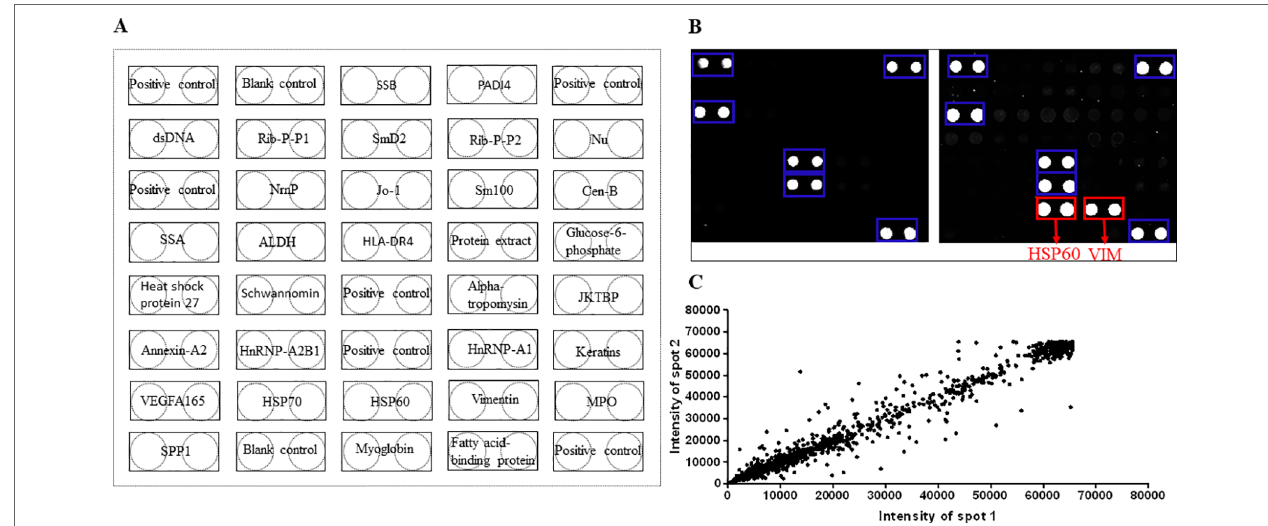
FIGURE 2 | Construction RA associated protein chip. (A) Human proteins were purified and printed in duplicate on poly-L-lysine coated microscope slides. (B) Correlation of spot intensities of all the duplicate pairs. The signal intensities of duplicate spots (Spot 1 versus its corresponding Spot 2) were plotted against each other. The resulting correlation coefficient was 0.97, indicating high reproducibility of the protein spotting. (C) To monitor the quality and relative quantity of the printed proteins on glass slides, the human protein chips were probed with anti-His antibody, followed by Cy3-labeled secondary antibody to visualize the signals, red boxes indicate HIS-tag group. Blue boxes indicate human IgG (the positive control), red boxes indicate HSP60 and VIM antibody. Sjogren syndrome antigen B = SSB, peptidyl arginine deiminase 4 = PADI4, double-stranded DNA = dsDNA, ribosomal protein P1 = Rib-P-P1, smithD2 = SmD2, ribosomal protein P2 = Rib-P-P2, nucleosome = Nu, nuclear ribonucleoprotein = NrnP, smith100 = Sm100, centromere protein b = Cen-B, sjogren syndrome antigen A = SSA, aldehyde dehydrogenase = ALDH, human leukocyte antigen-DR4 = HLA-DR4, isoform of heterogeneous nuclear ribonucleoprotein D-like = JKTBP, heterogeneous nuclear